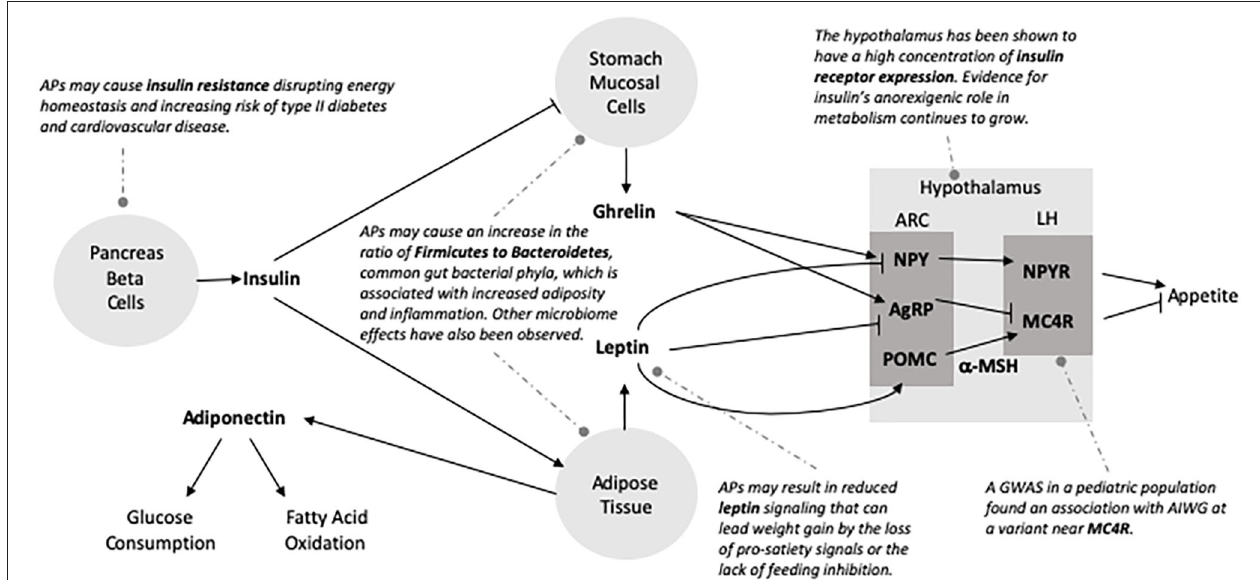
FIGURE 1 | The associated burden of pediatric antipsychotic treatment. Antipsychotic use is associated with weight gain, increased fasting lipids (total cholesterol, LDL, and triglyceride levels), and impaired glucose tolerance in pediatric patients. Subsequently, this population is at an increased risk of obesity, metabolic syndrome and type 2 diabetes. Although pediatric patients are more vulnerable to these adverse side effects, they are less likely to have their metabolic parameters monitored during AP